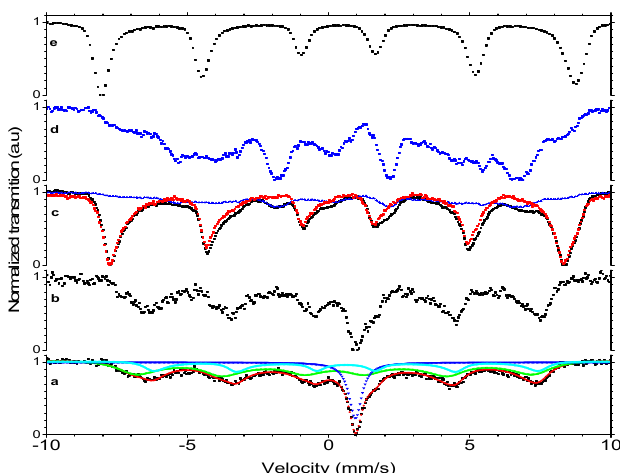
Figure 3. Mössbauer spectra of the magnetic nanoparticles (experimental points are represented by black dots): ( a ) at room temperature (RT) with the fit of wüstite singlet (blue), magnetite sextets (light blue and green), and their sum (red); ( b ) at RT after eight months of sample storage; ( c ) at liquid nitrogen temperature (LNT) with wüstite contribution (blue) and the spectrum after its subtraction (red); ( d ) the spectrum of microcrystalline wüstite at LNT; ( e ) the spectrum of microcrystalline maghemite, γ -Fe 2 O 3 , at LNT .